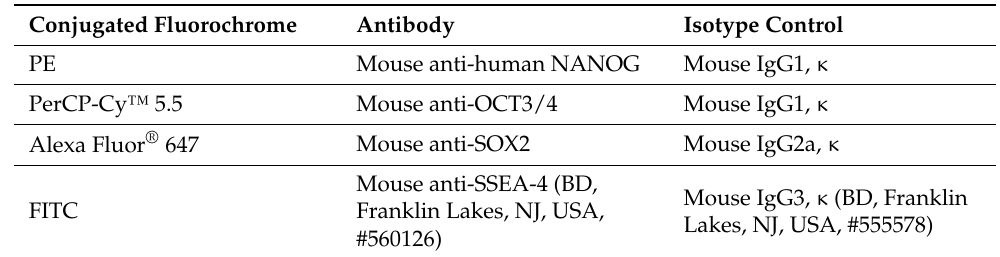
Table 5. Antibodies and isotype controls used for flow cytometry analysis of human induced pluripotent stem cells